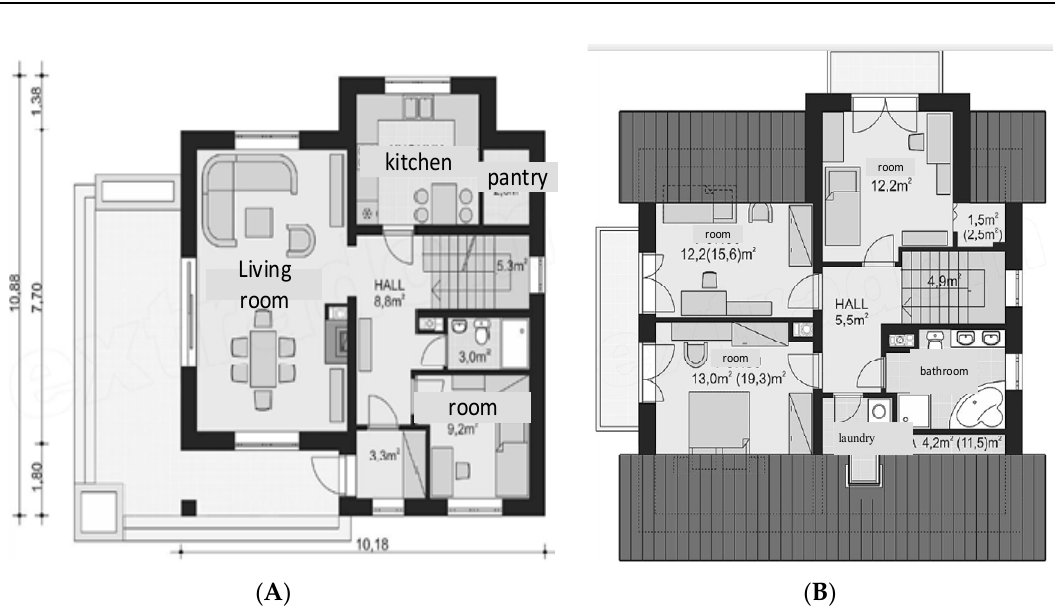
Figure 1. Buildings external partitions (B1 and B2). ( A ) Before thermo-modernization. ( B ) After Figure 1. (A ) Ground floor plan, ( B ) Attic floor plan. Source: Reference [32]. thermo-modernization. 1. Cellular concrete blocks; 2. Plaster; 3. Thermal